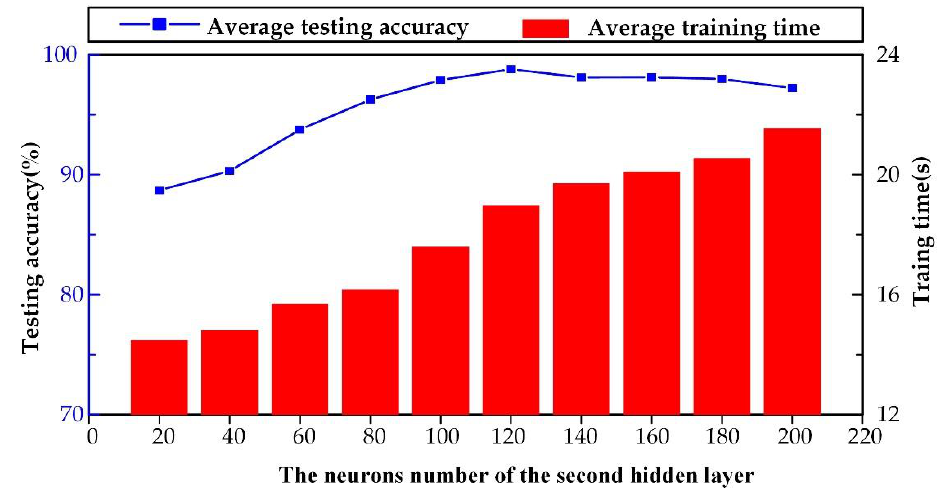
Figure 12. The results of the effect of number of neurons of the second hidden layer on the recognition accuracy and calculation time.